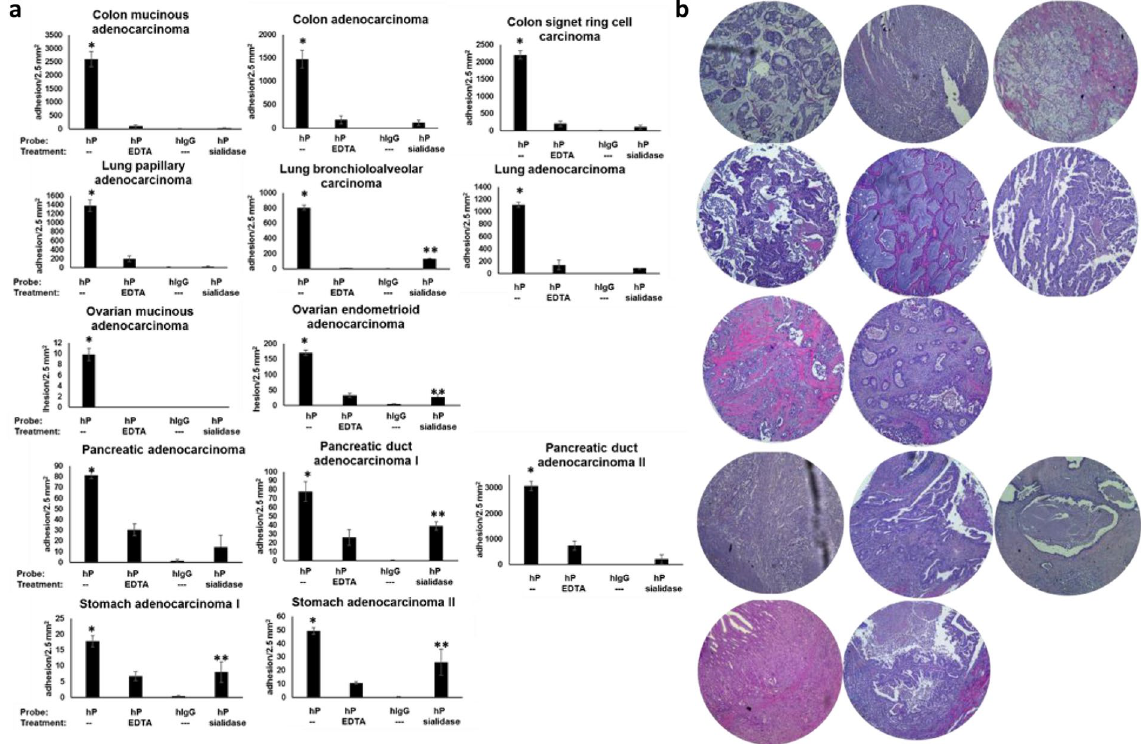
Figure 6. P-selectin DBTA probes specifically adhere to consecutive serial sections of colon, lung, ovarian, pancreatic, and stomach cancer tissues. ( a ) Functional P-selectin ligands are expressed on colon, lung, ovarian, pancreatic, and stomach cancer tissues. DBTA probes were perfused over three serial sections at 0.50 dyne/cm 2 and 500,000 probes/mL. Specificity of interaction was confirmed using 10 mM EDTA, hIgG DBTA probes, and human P-selectin (hP) DBTA probes perfused over sialidase-treated tissue as negative controls. Data shown are mean adhesion ± SEM of three technical replicates from each of three independent serial sections. * and ** P < 0.05 for P-selectin (hP) with respect to the three controls (hP to hP + EDTA, hIgG, and hP + sialidase) and the sialidase-treated tissue with respect to hIgG and hP + EDTA, respectively. See Supplementary Table S1 for P-values and Supplementary Videos S12–S17 for adhesion patterns. ( b ) Corresponding H&E images on the right are shown in the same order as ( a ). Core diameter is 2.5